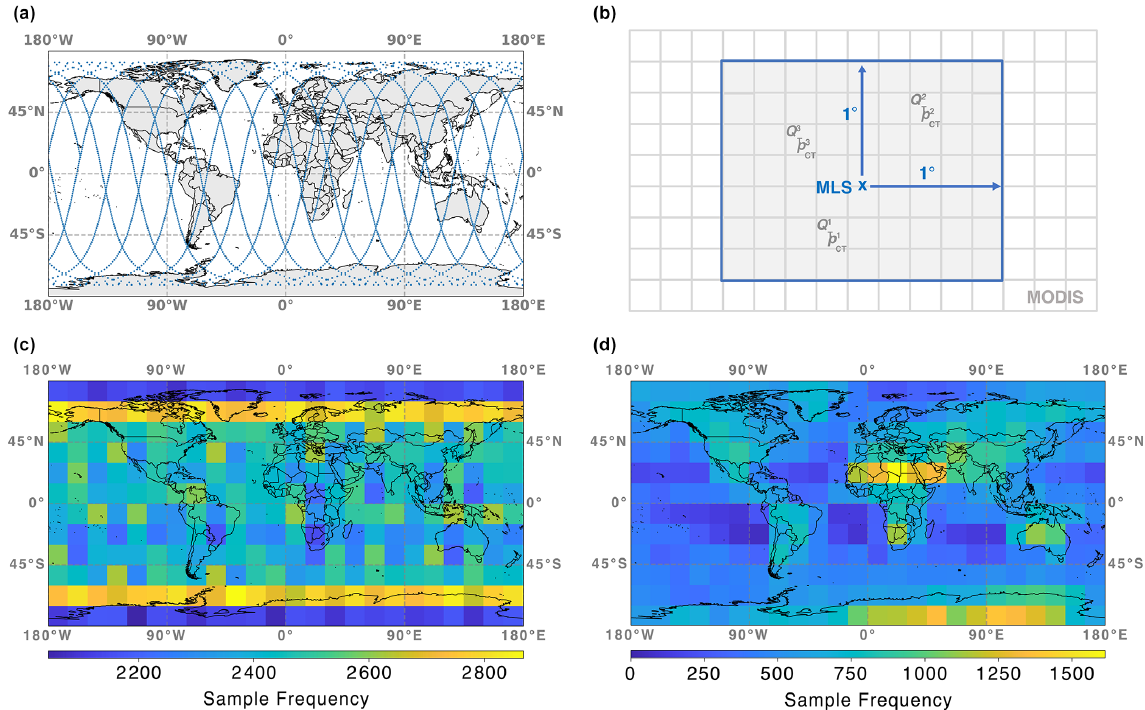
Figure 2. (a) Example MLS orbit on 19 May 2019. (b) Illustration of the colocation of MLS and MODIS data. (c) Global map of sample frequencies for the colocated MLS–MODIS data set used in this study. (d) Same as (c) but showing the sample frequencies of observed clear and cloudy profiles, following the definitions in Sect.